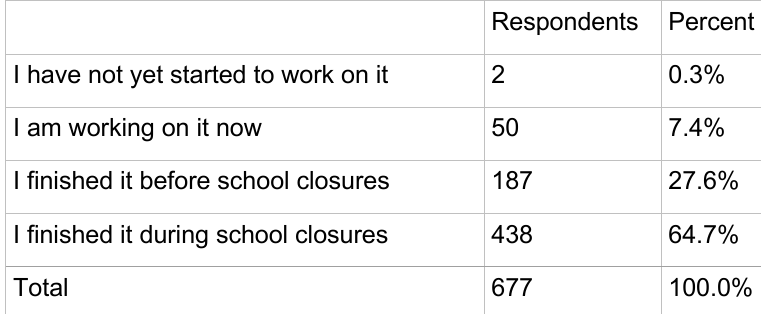
Table 1: Third-year students’ responses to the question: ‘How far have you got with your SRP/SOP?’ Another central element of our data collection was based on qualitative data. In the spring of 2020, we collected data on three students selected to answer this article’s research questions as part of a qualitative ethnographic doctoral project (Bang-Larsen, 2022). Data involved student notes, instructions, assignments, observation of online supervision, and interviews, as illustrated in Table 2. This part of the data was chosen to explore the discrepancies between the results of the quantitative part of the study and previous studies. As we discuss below, these discrepancies are related to accessibility and